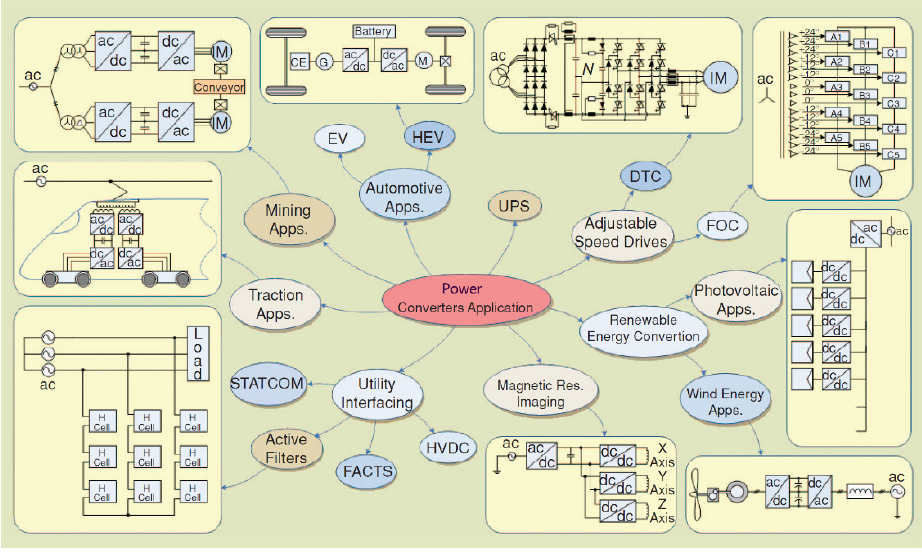
Figure 1. Power converters application.